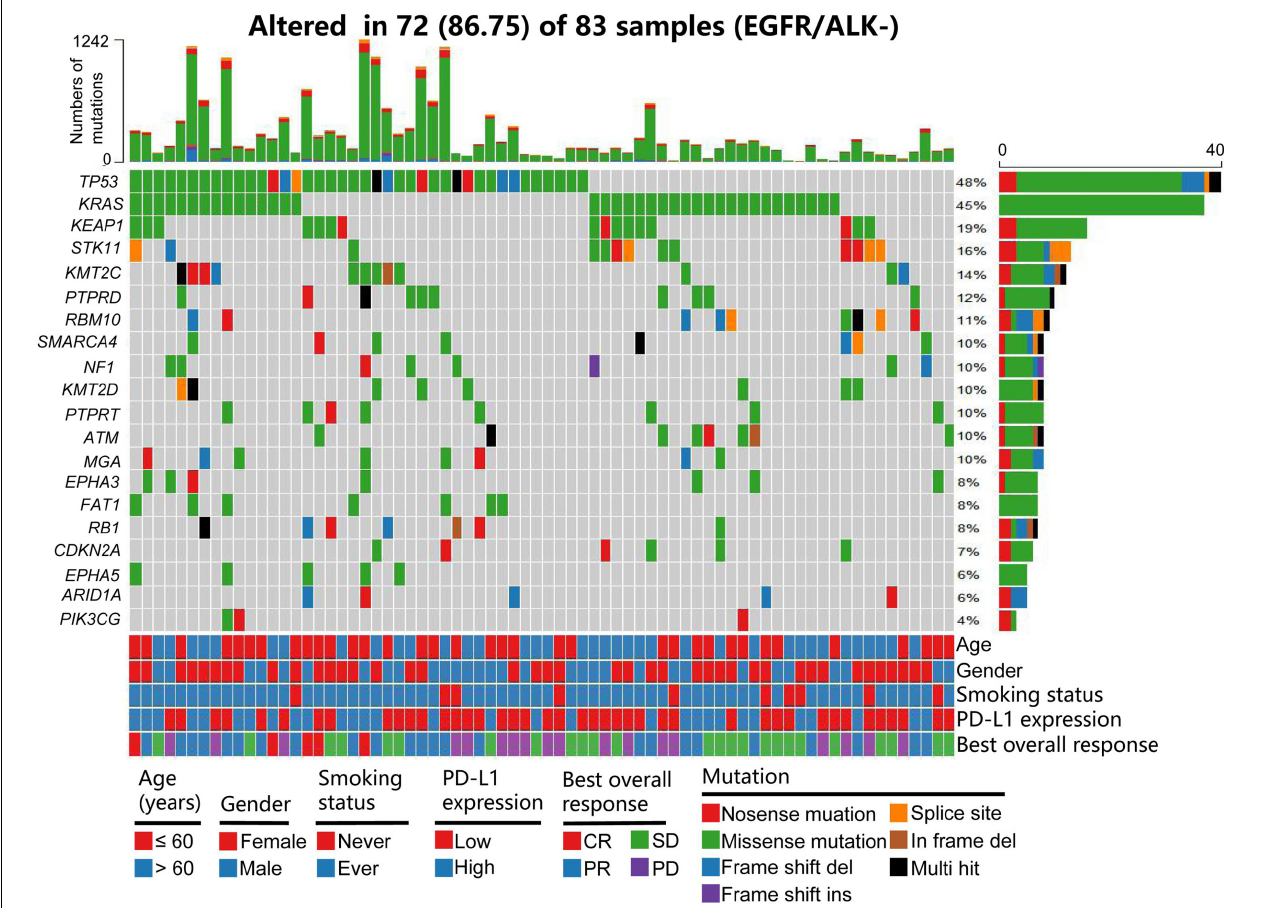
FIGURE 1 | Summary of clinical and molecular features associated with response of ICI-based therapy in the training cohort with patients with EGFR/ALK-negative non-squamous NSCLC. Individual patients are represented in each column. Age is stratified as ≤ 60 years or > 6 years; sex as female and male; smoking status as ever and never; PD-L1 expression as 0–49% or ≥ 50%; and BOR as CR, PR, SD, and PD. Mutations include 7 mutational subtypes, and the TMB of each patient is calculated. The occurrences of top 20 genes in each case are represented in the OncoPrint. PD-L1, programmed cell death-ligand 1; NSCLC, non-small cell lung cancer; BOR, best overall response; CR, complete response; PR, partial response; SD, stable disease; PD, progressive disease; TMB, tumor mutation